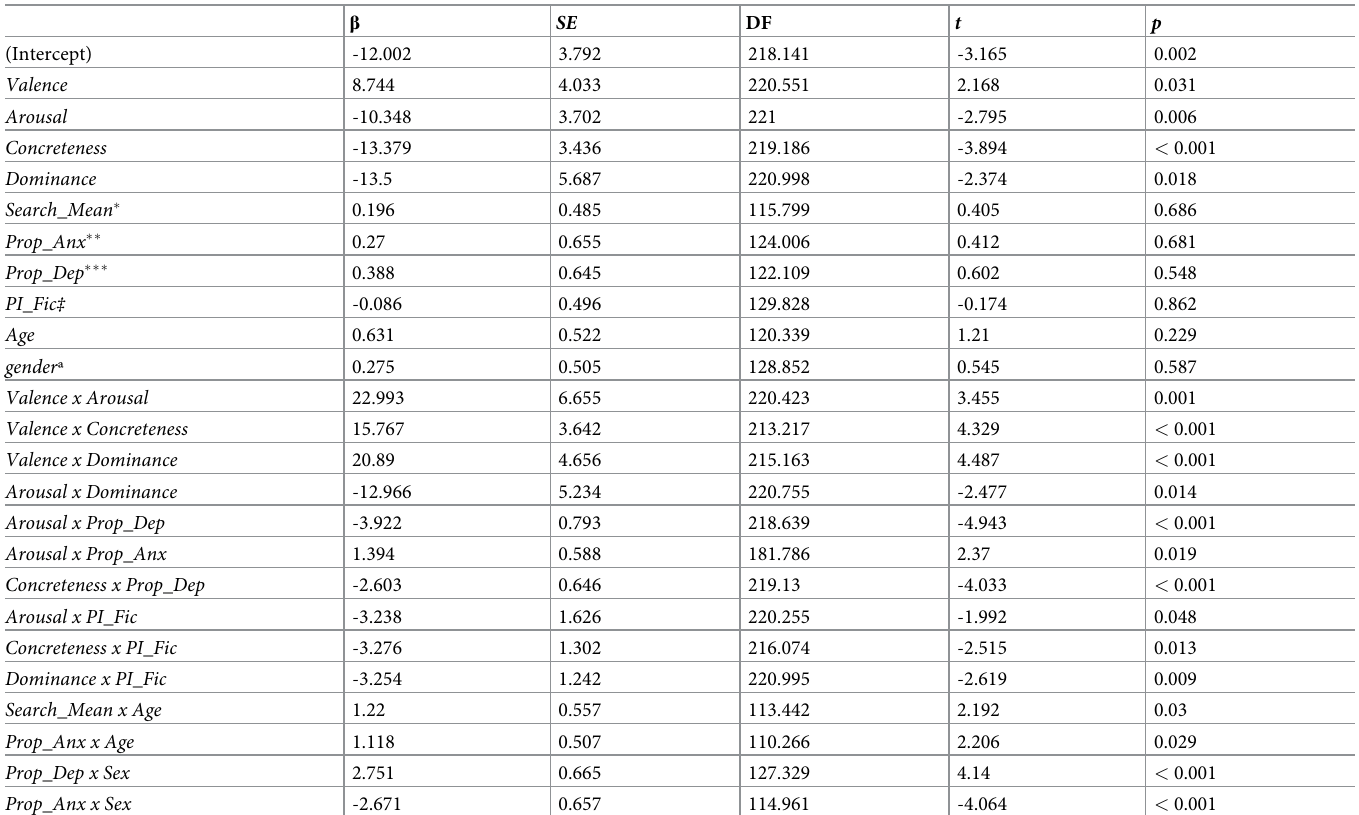
Table 2. Results of exploratory multilevel model selection procedure in Study